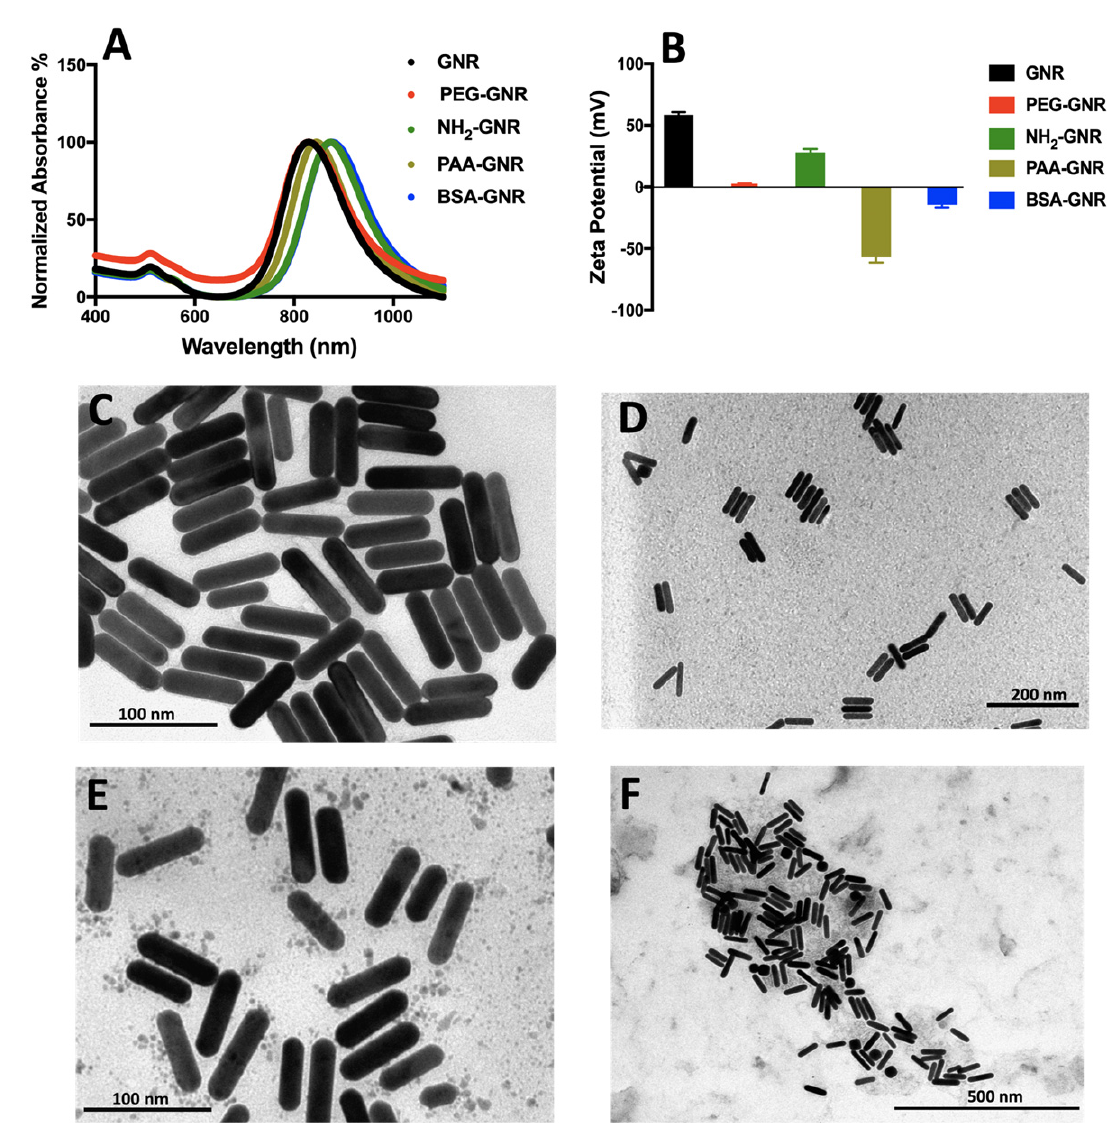
Figure 1. ( A ) UV-vis absorption spectra of GNR, PEG-GNR, NH 2 -GNR, PAA-GNR and BSA-GNR indicate typical transverse and longitudinal peaks of the nanorods. ( B ) Zeta potential of GNR of di ff erent surface modifications; GNR, PEG-GNR, NH 2 -GNR, PAA-GNR and BSA-GNR. ( C ) TEM image of PEG-GNR. ( D ) TEM image of NH 2 -GNR. ( E ) TEM image of PAA-GNR. ( F ) TEM image of